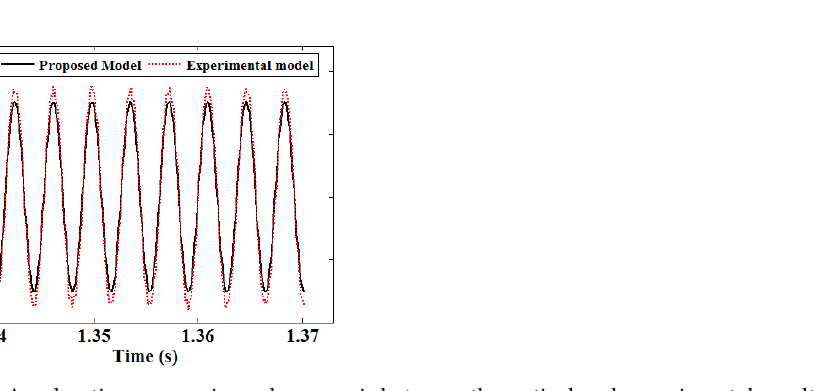
Figure 8. Acceleration comparison along z -axis between theoretical and experimental results.